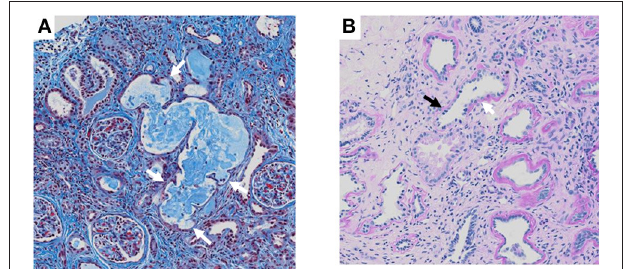
FIGURE 2 | Renal biopsy histopathology. (A) Masson staining section showing irregular tubular dilatation with diverticular outpouchings (white arrow). (B) Periodic acid silver staining section showing thickening (white arrow) and thinning (black arrow) of tubular basement membrane and chronic interstitial inflammation.